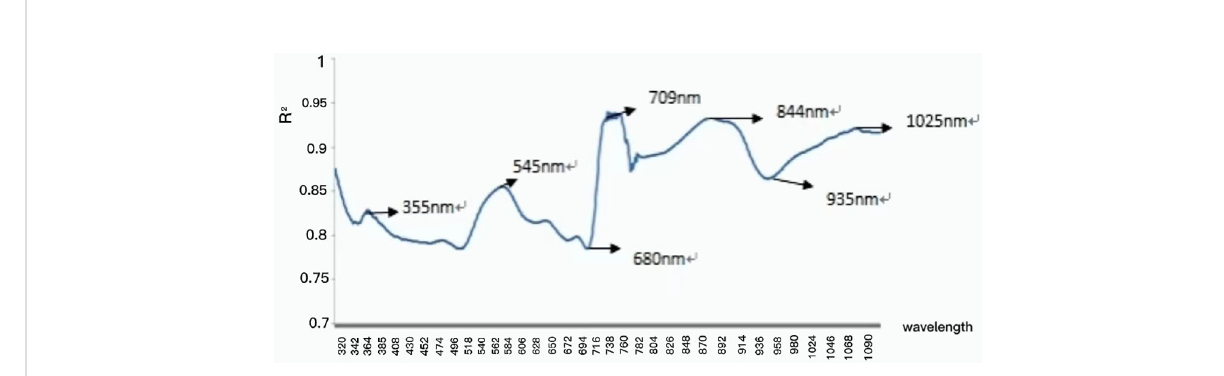
FIGURE 3 Correlation between logarithmic spectral re fl ectance and moisture content of drying